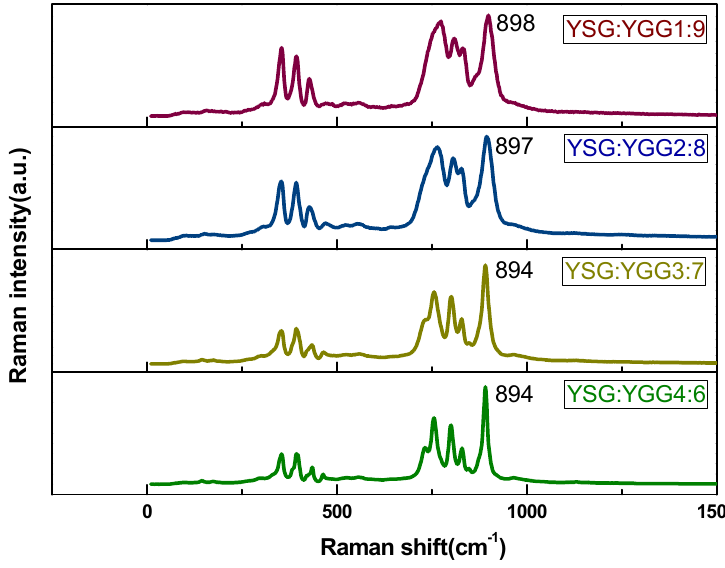
Figure 11. Raman spectra of Er 3+ -doped YSG:YGG from 1:9 to 4:6.